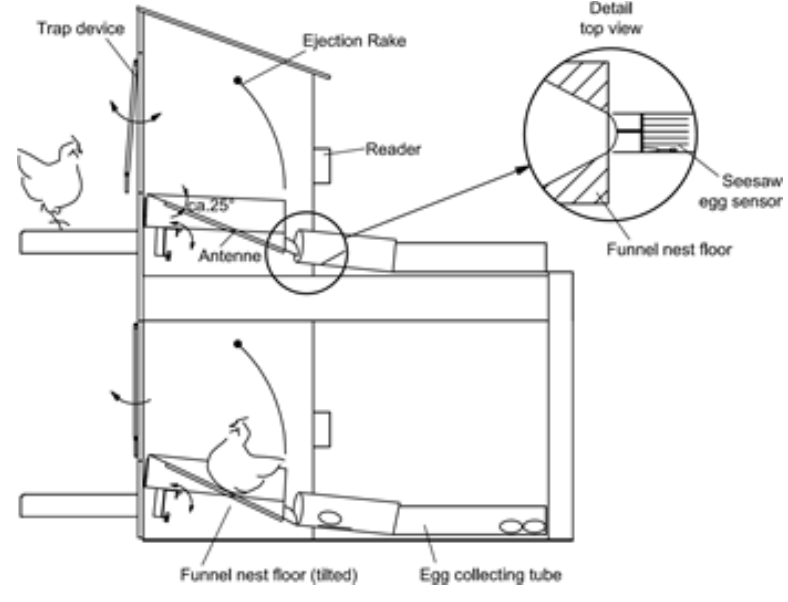
Figure 3. Schematic diagram of the funnel nest box [55].